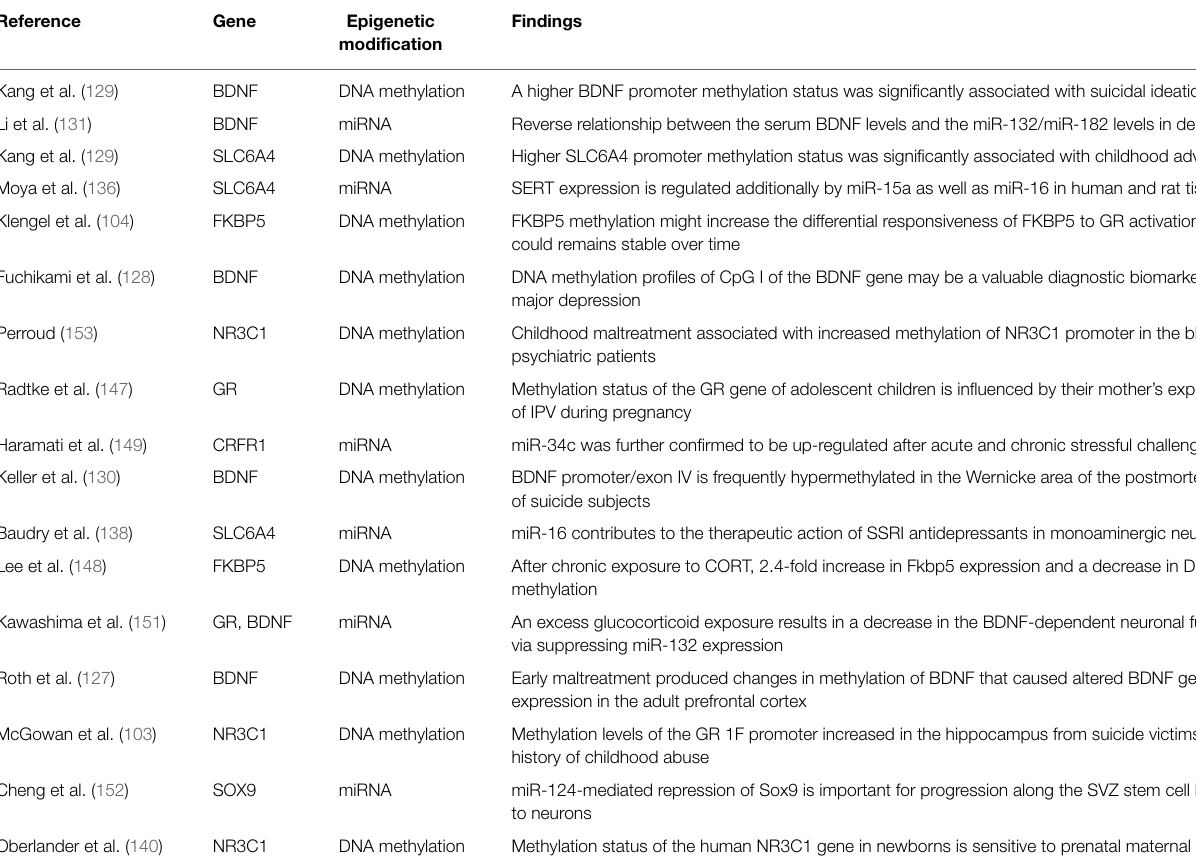
TABLE 2 | Correlation between epigenetic modification, stress, and genetics